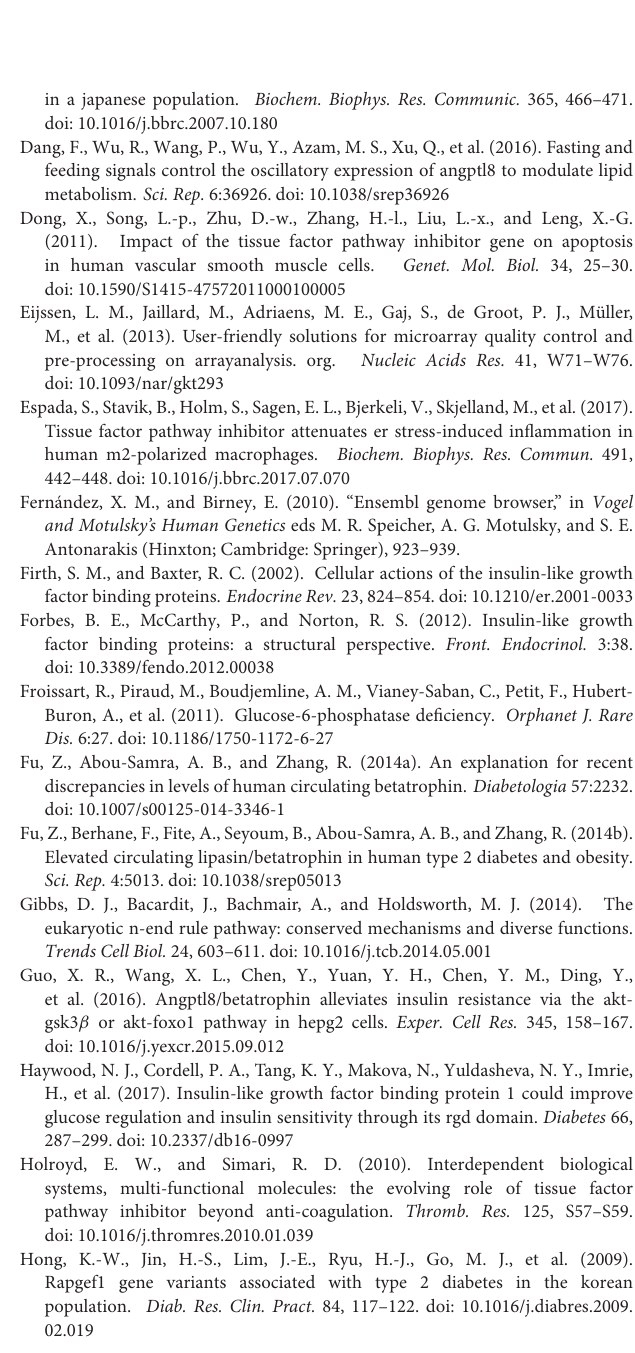
Data Sheet 4 | List of genes to SNPs analysis performed on the selection of genes from ANGPTL8 genes co-expression module. Data Sheet 5 | Lists of the genes in corresponding modules identified through WGCNA. Data Sheet 6 | The Gene Ontology analysis of the ANGPTL8 associated genes co-expression module.